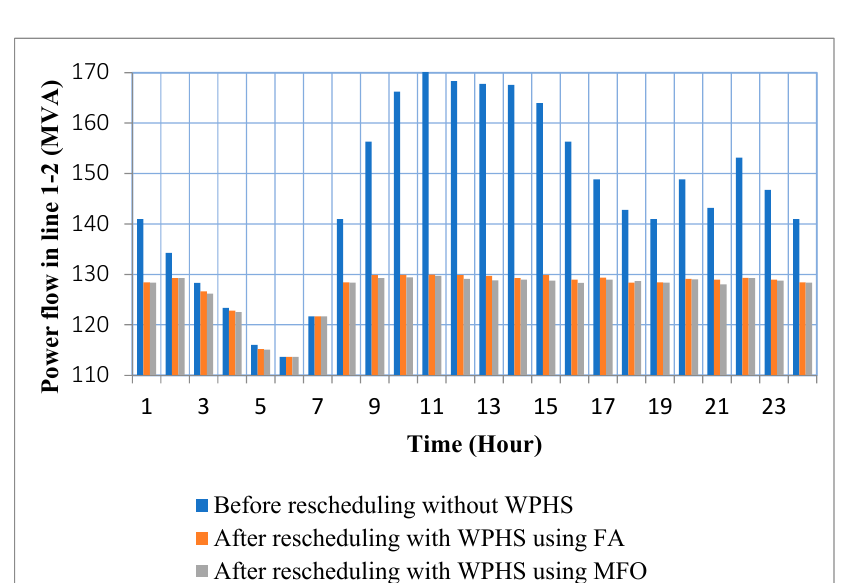
Figure 10. Power flow in line 1–2 before and after rescheduling with and without WPHS.